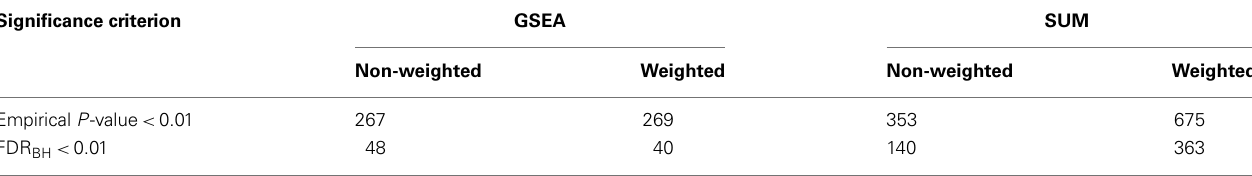
TableA1 | Number of pathways at different cut-off in four statistical scenarios (total number of pathways = 4051). Significance criterion